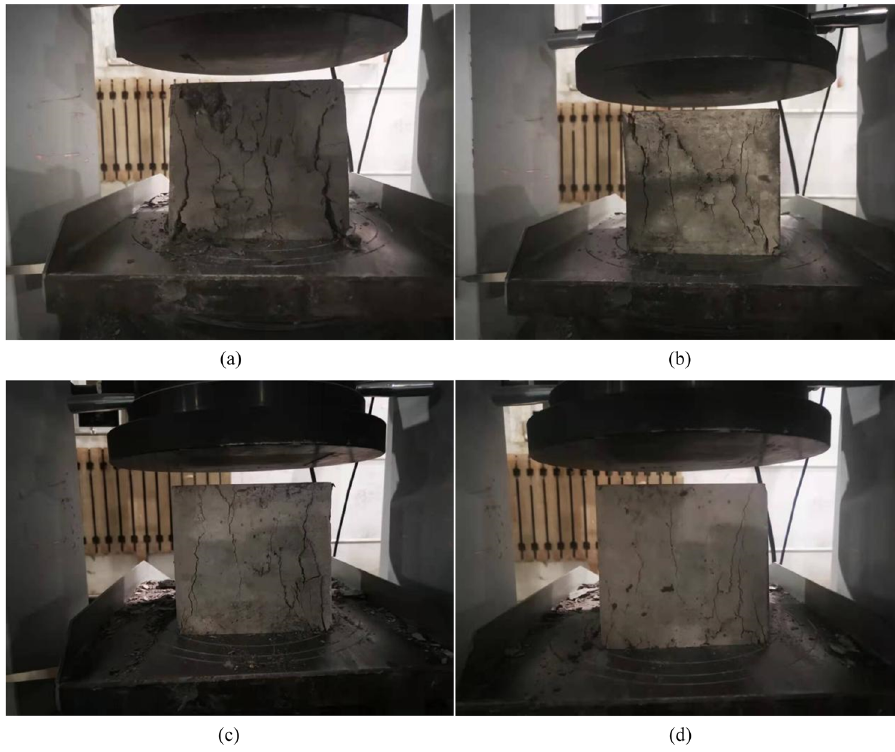
Figure 16: Cubic compression failure modes of RAC. ( a ) NS0BF0, ( b ) NS2BF0, ( c ) NS0BF12 - 2, ( d ) NS2BF12 -